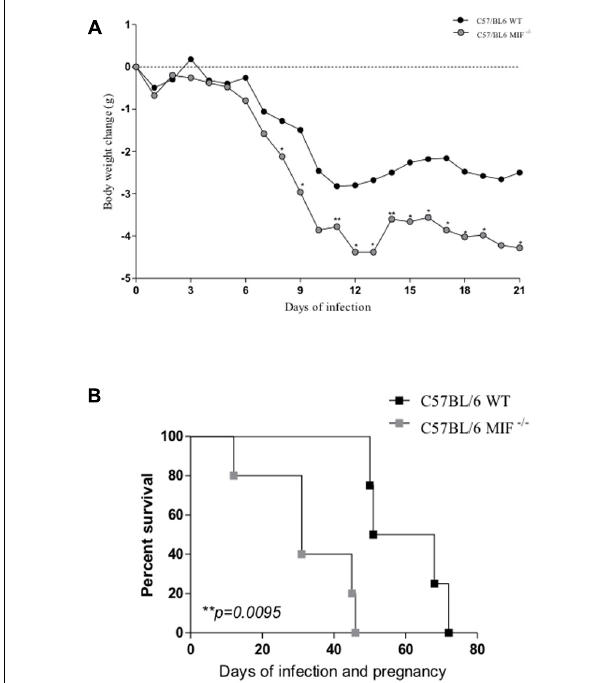
FIGURE 1 | (A) Change in body weight in C57BL/6 MIF − / − and C57BL/6 WT mice orally infected with 10 cysts of strain ME49 of Toxoplasma gondii. Animals were monitored for 21 days, and the results are presented as the mean of data obtained from 5 animals in each group. Asterisks indicate significant differences between MIF − / − and WT mice (Mann–Whitney test; ∗ P < 0.05; ∗∗ P < 0.01). (B) Kaplan–Meier survival curve of infected/pregnant mice. MIF − / − and WT females ( n = 5 animals per group) were orally infected with five cysts of T. gondii (ME49 strain) on the first day of pregnancy and monitored for 80 days after infection. Data were analyzed with a log-rank test. Differences were considered significant if P < 0.05 ( ∗